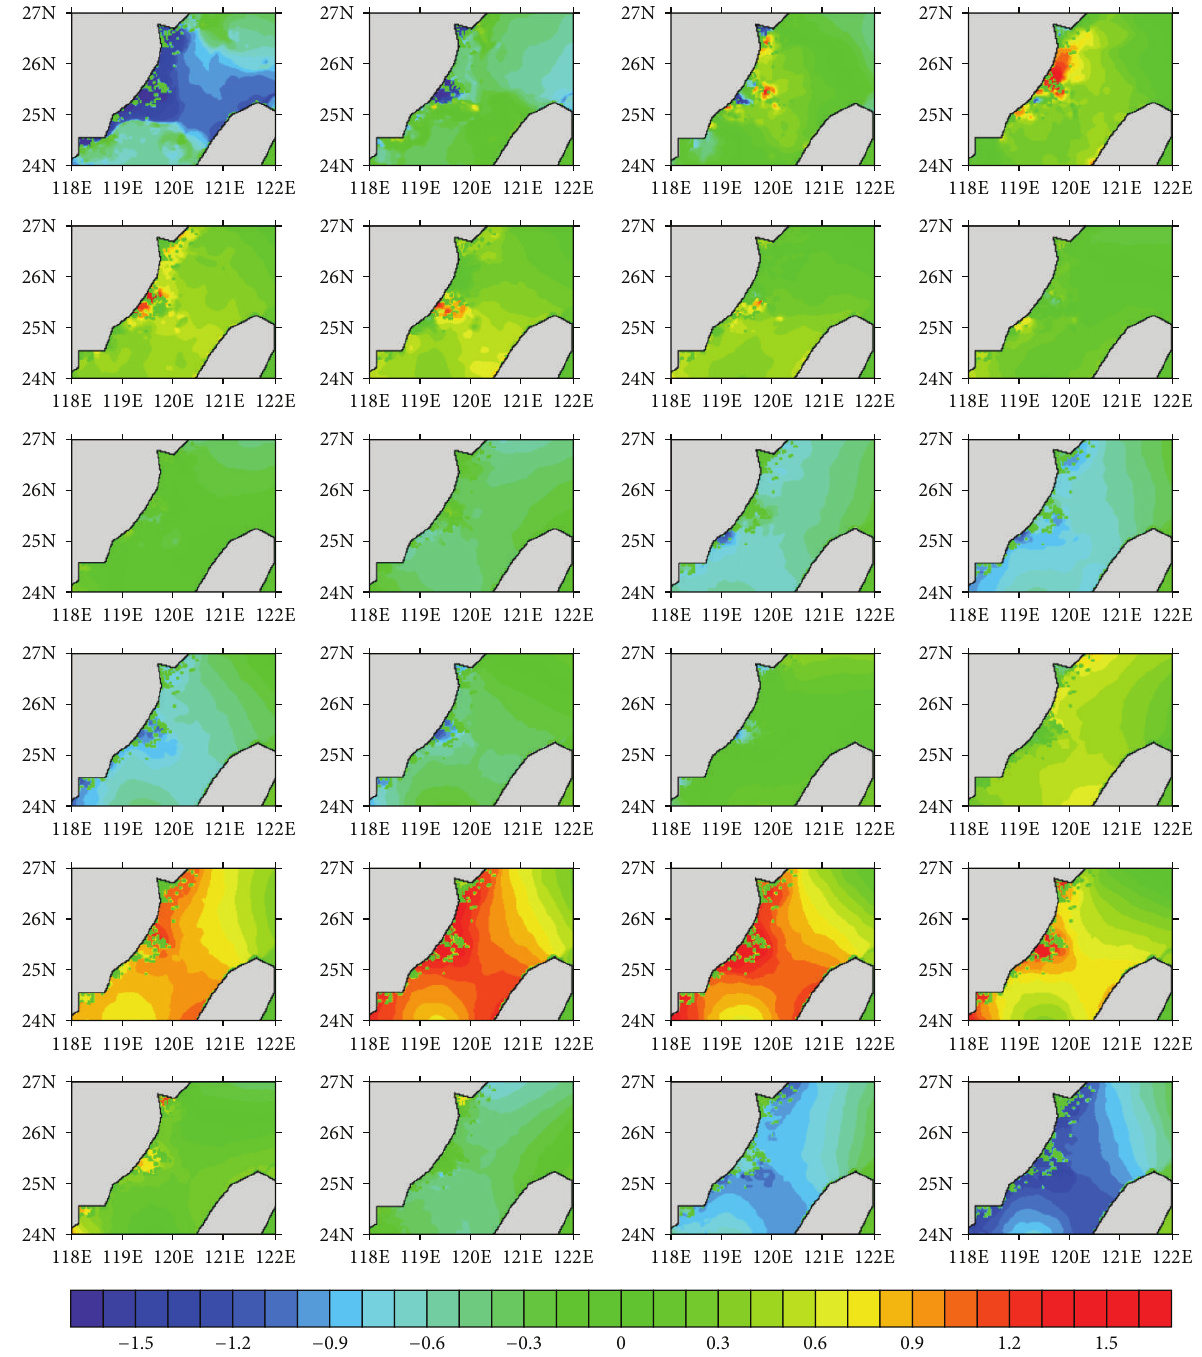
Figure 3: Sea level series in July 13, 2013. Output from Experiment 2 which is forced by HY-2 winds. (Units: m; from left to right and from top to bottom, the plot, resp., presents the situation of 1, 2, 3, ... ,24 o’clock.)